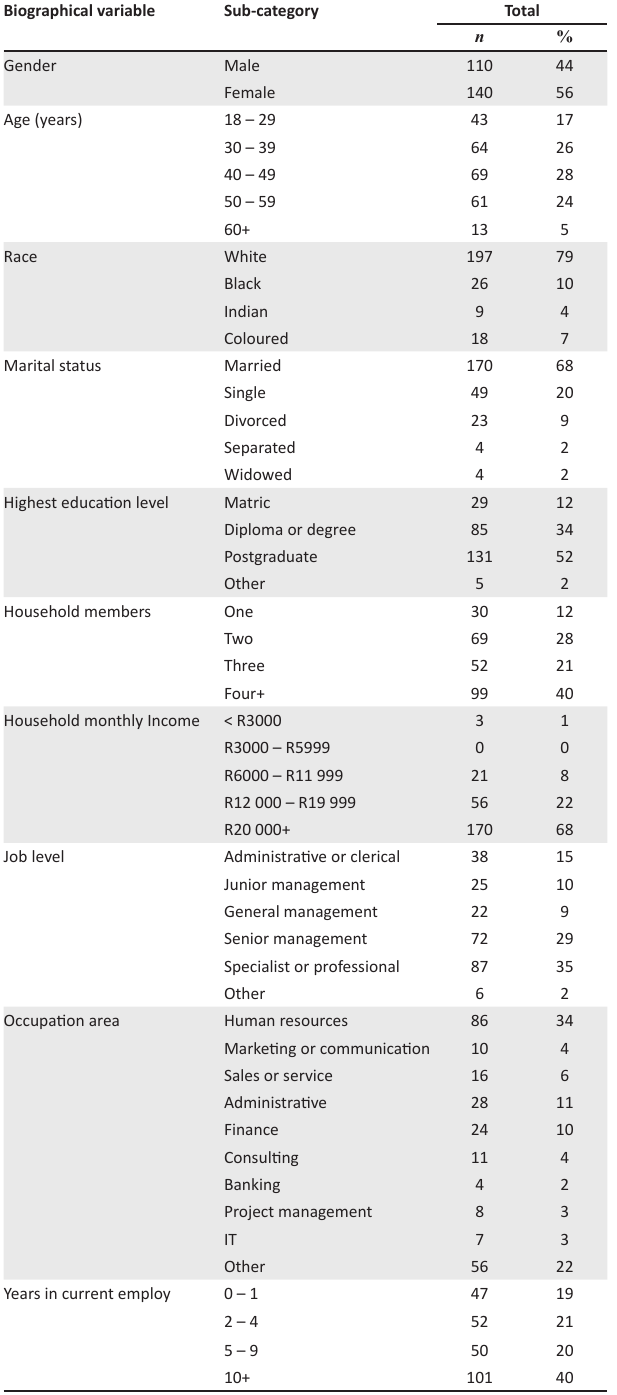
TABLE 1: Biological profile of the study